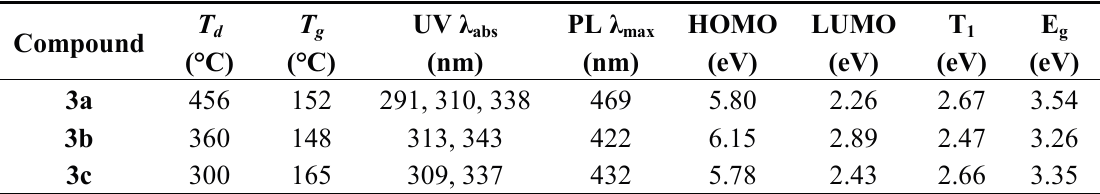
Table 1. Thermal and photophysical properties of HTMs 3